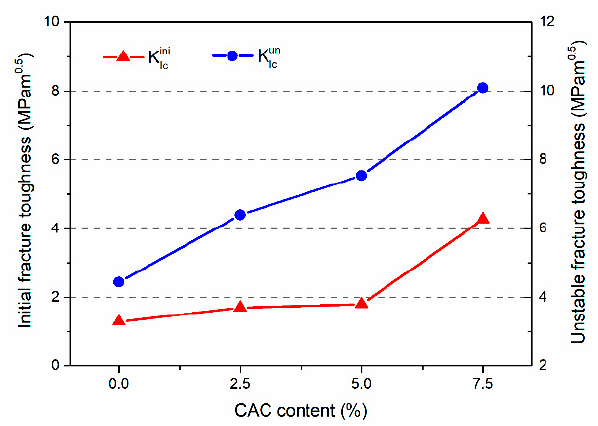
Figure 10. Fracture toughness of FAGC with different CAC contents.